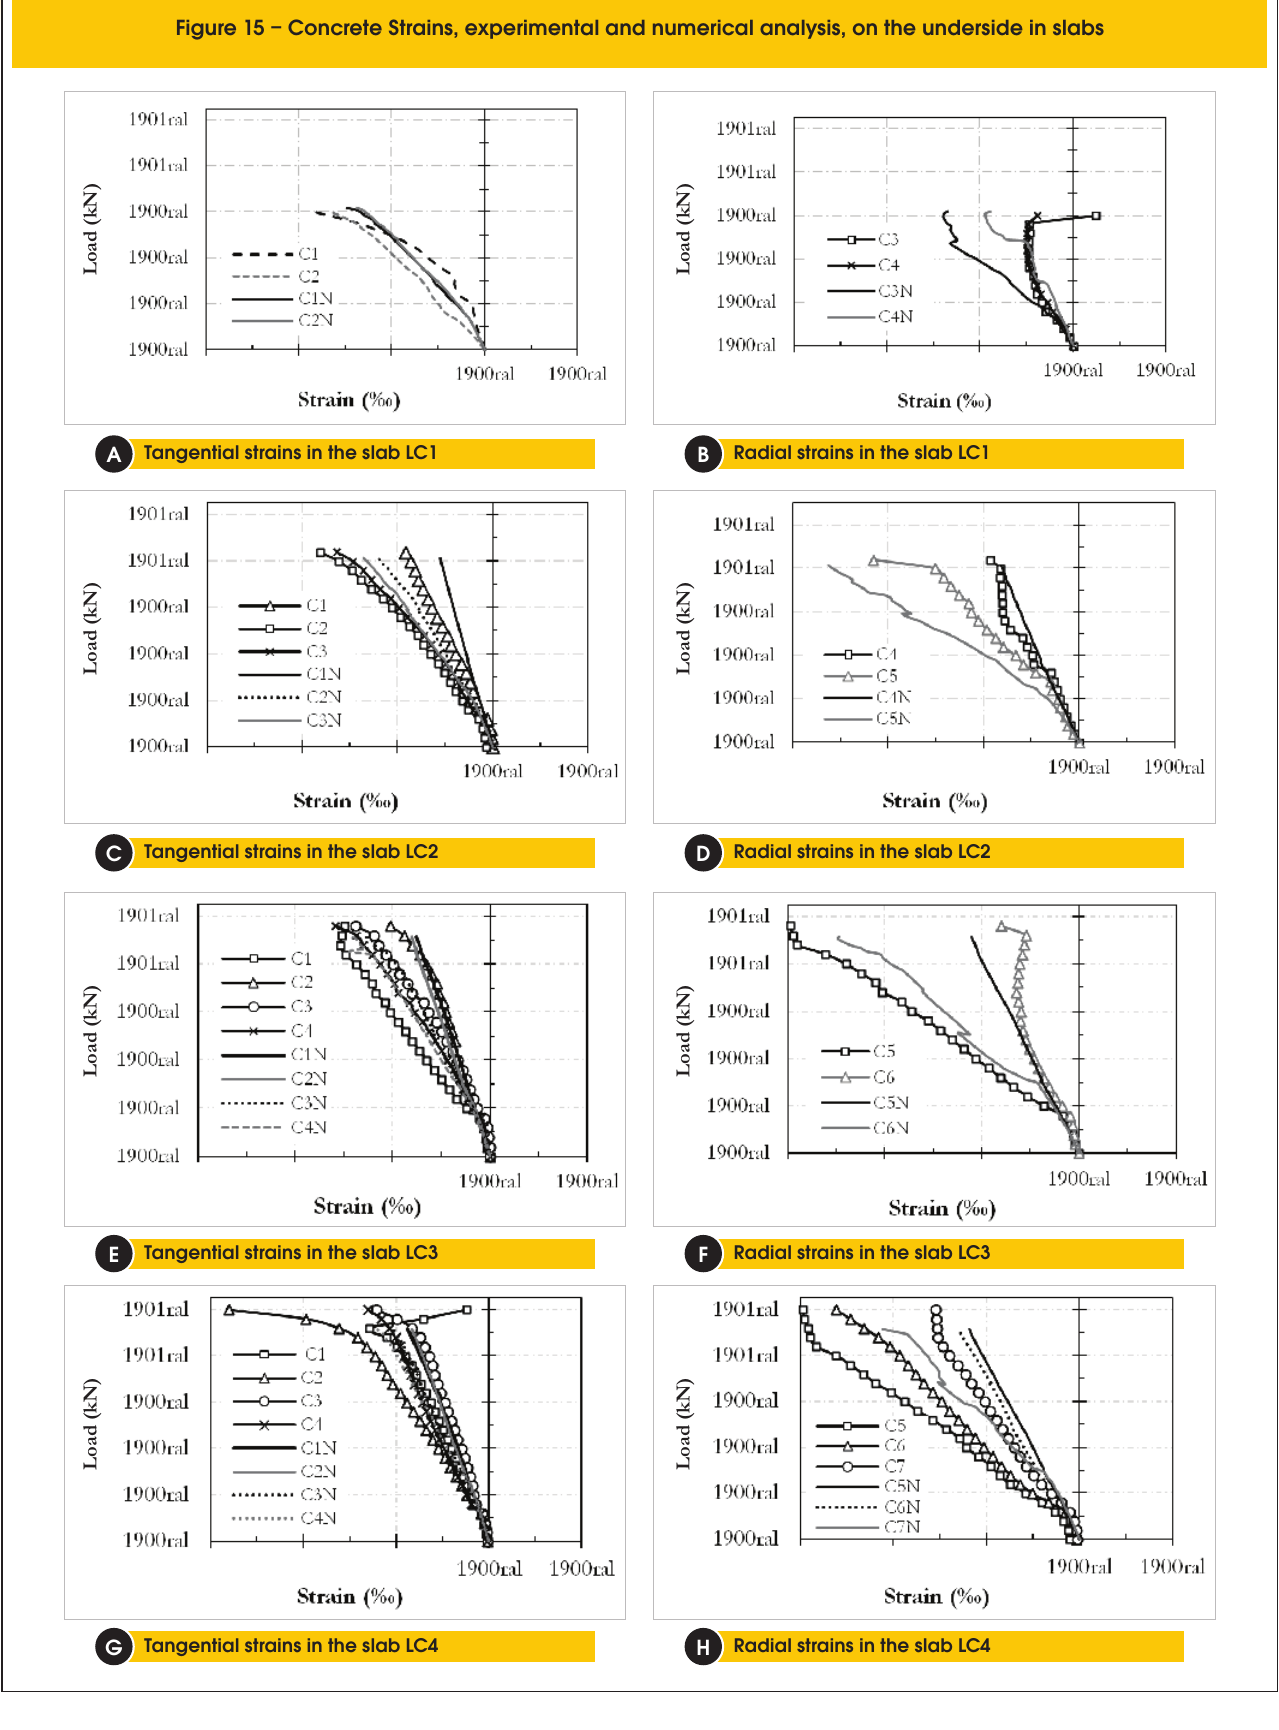
Figure 15 – Concrete Strains, experimental and numerical analysis, on the underside in